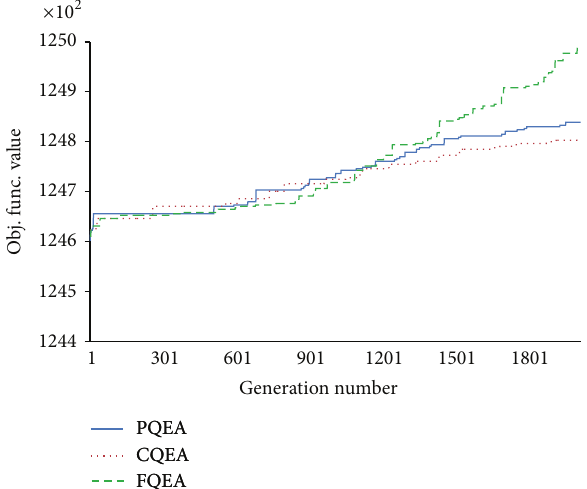
Figure 32: Convergence graph of PQEA, CQEA, and FQEA on 0-1 knapsack problem with profit ceiling data instances with number of items, 𝑀 , being 5000 and capacity, 𝐶 , being 2% of total